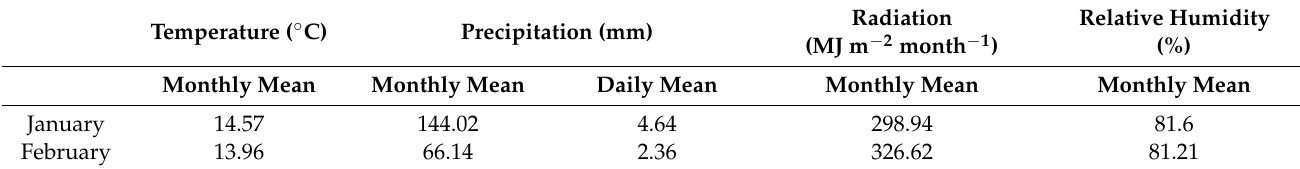
Figure 1. The Chiayi County in Taiwan. Table 1. Meteorological parameters of the Chiayi